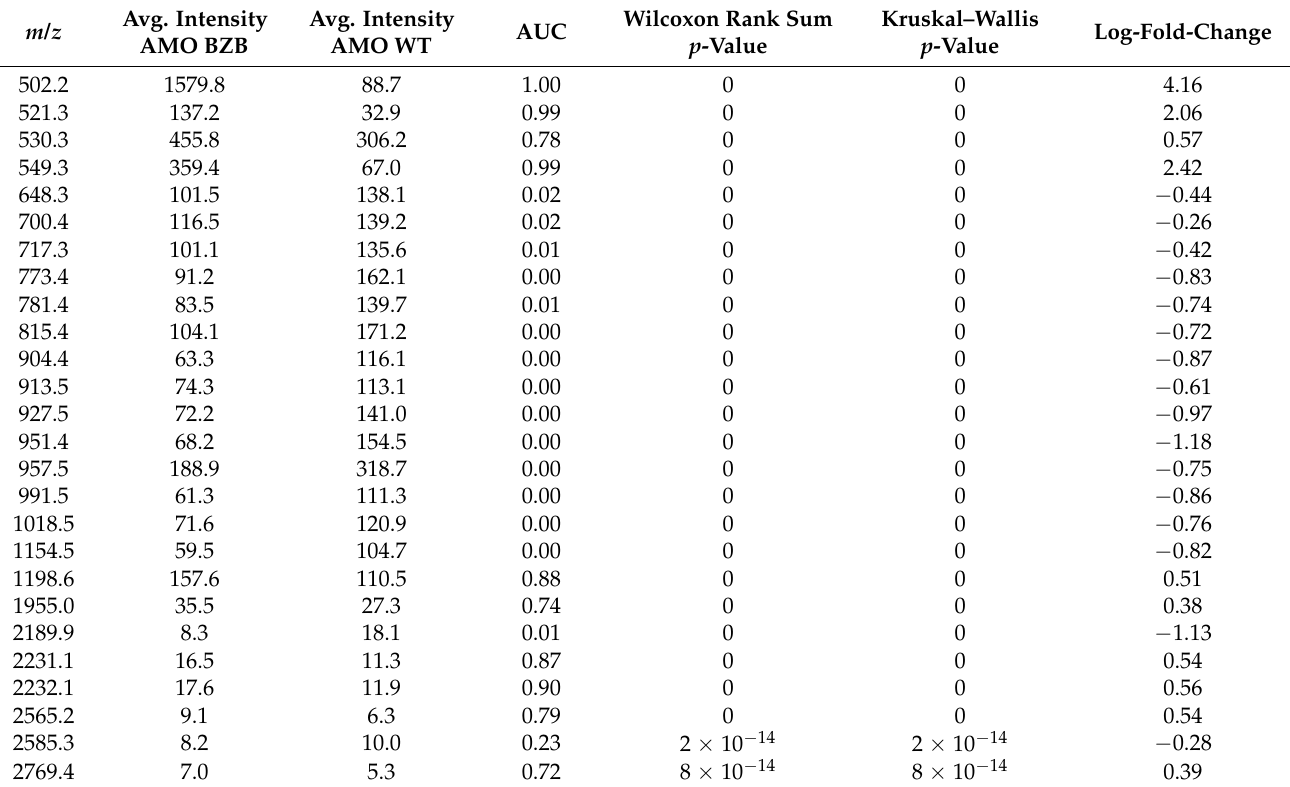
Table 1. Statistical analysis revealed differentially expressed m/z species between AMO BZB and AMO WT cell lines. Average intensities, AUC, and p -values were combined from replicate